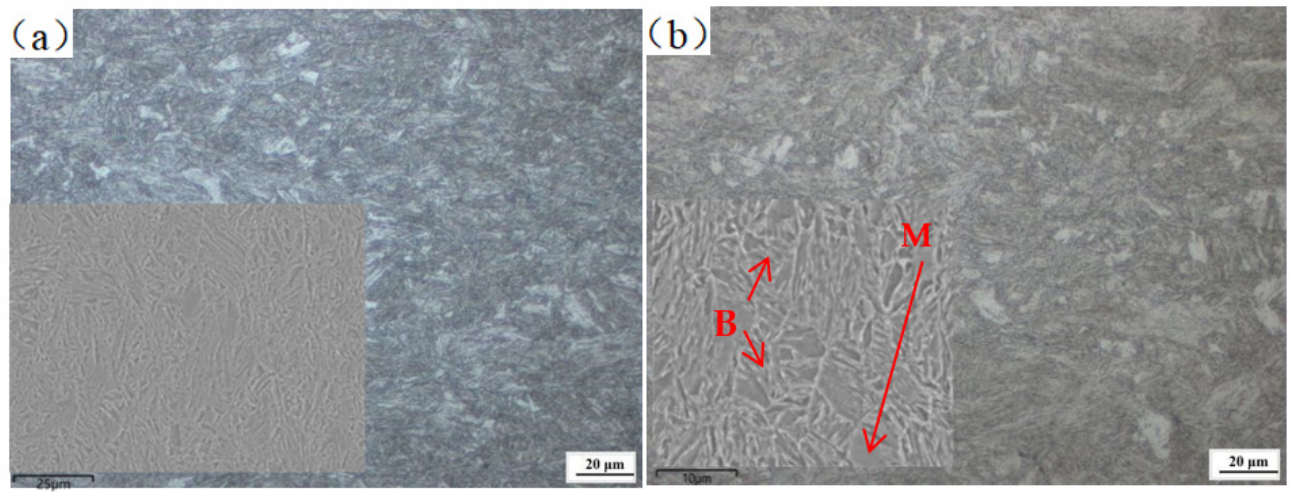
Table 2. Mechanical properties of tested steels.